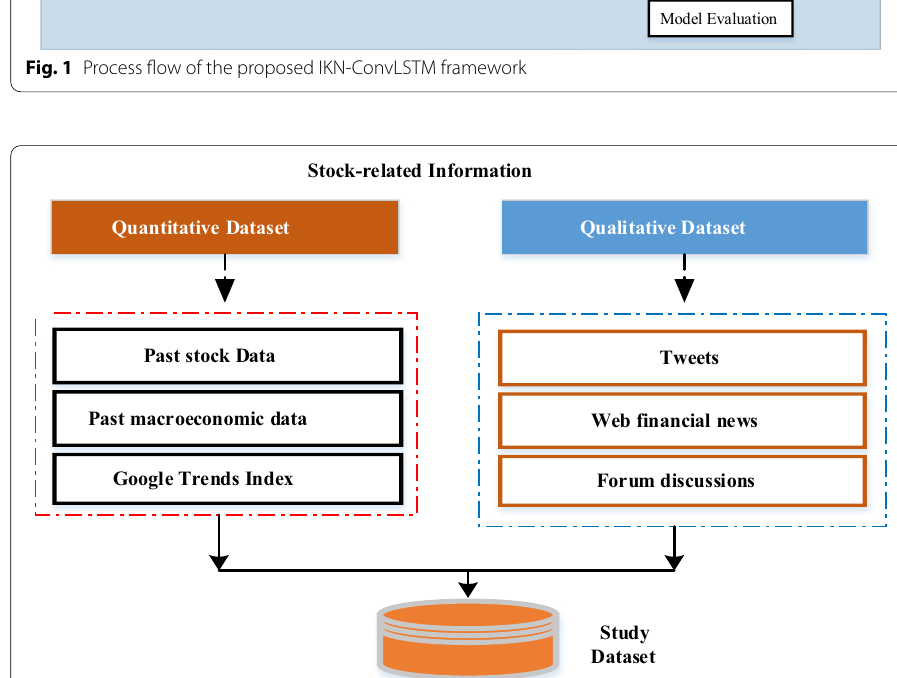
Fig. 2 Proposed heterogeneous sock-related information data